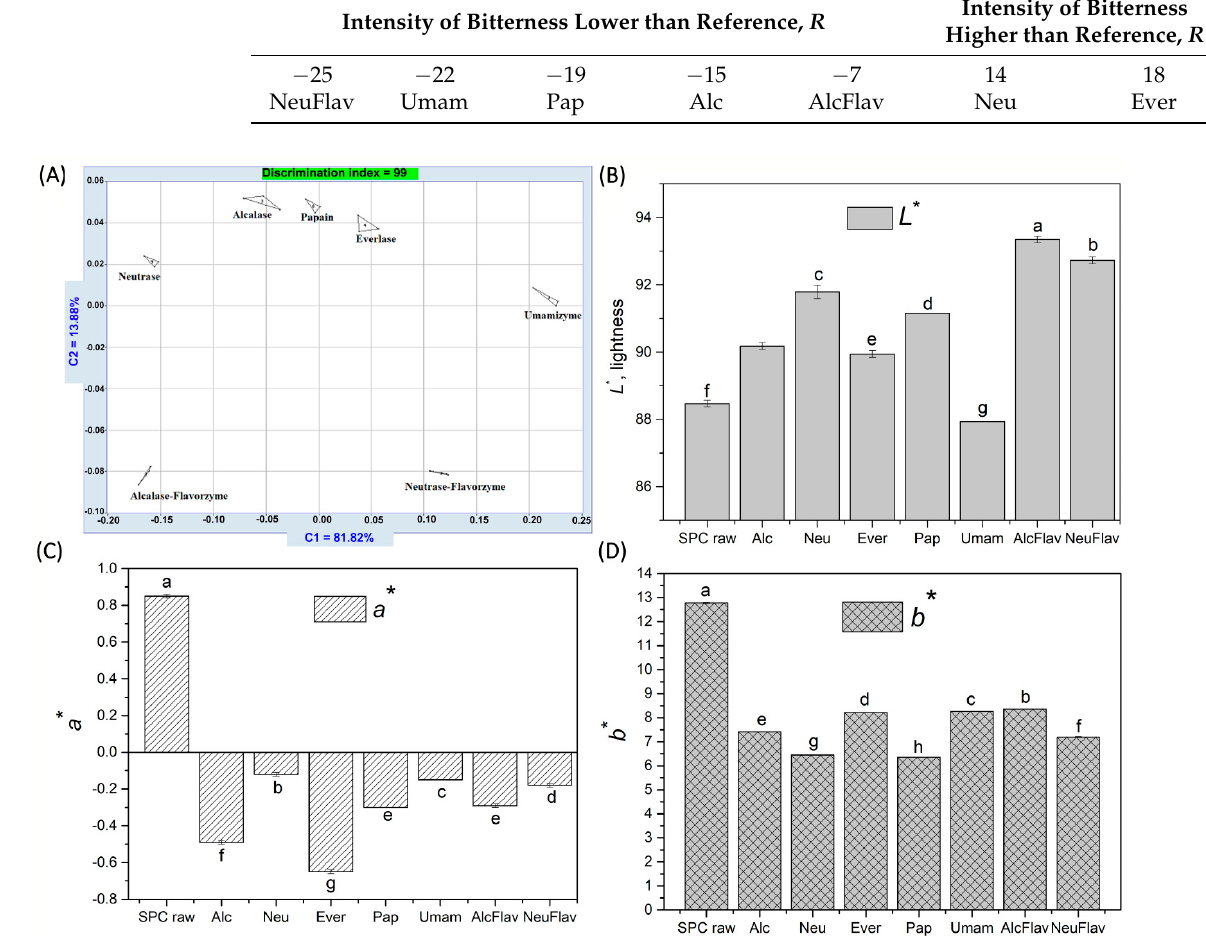
Figure 3. ( A ) PCA plot of hydrolysates (discrimination index = 93); color parameters of soy protein hydrolysates and SPC: ( B ) L *, lightness; ( C ) a *, red hue value; ( D ) b * yellow hue value. The results of color measuring are expressed as mean ± standard deviation ( n = 10). Samples with different letters are significantly different from each other at level